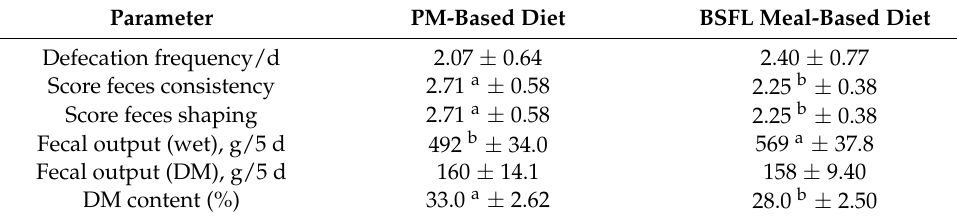
Table 7. Fecal characteristics of dogs fed the experimental diets (mean ± SD). Parameter PM-Based Diet BSFL Meal-Based Diet Defecation